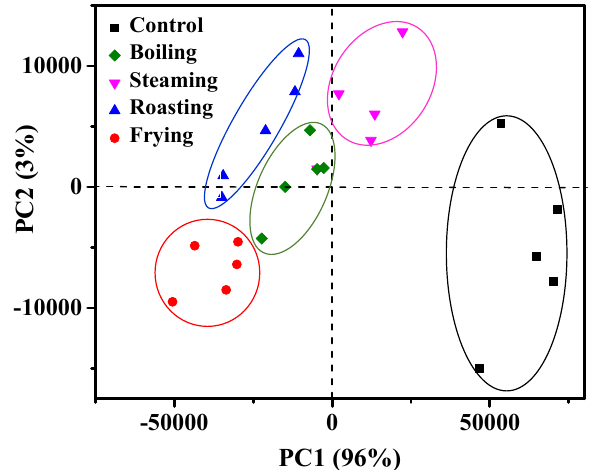
Figure 7. Principal component PC1 and PC2 scores plot from principal component analysis of fish samples with boiling, steaming, roasting, frying. Control is sample without heating treatment.